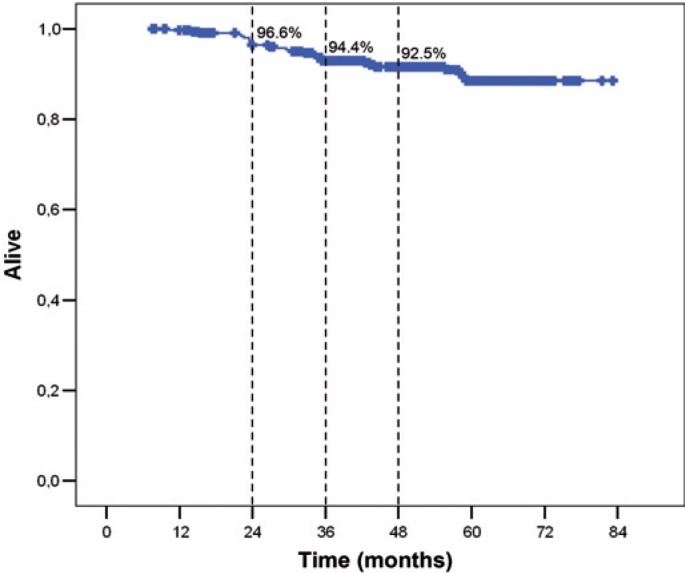
Overall survival (OS).